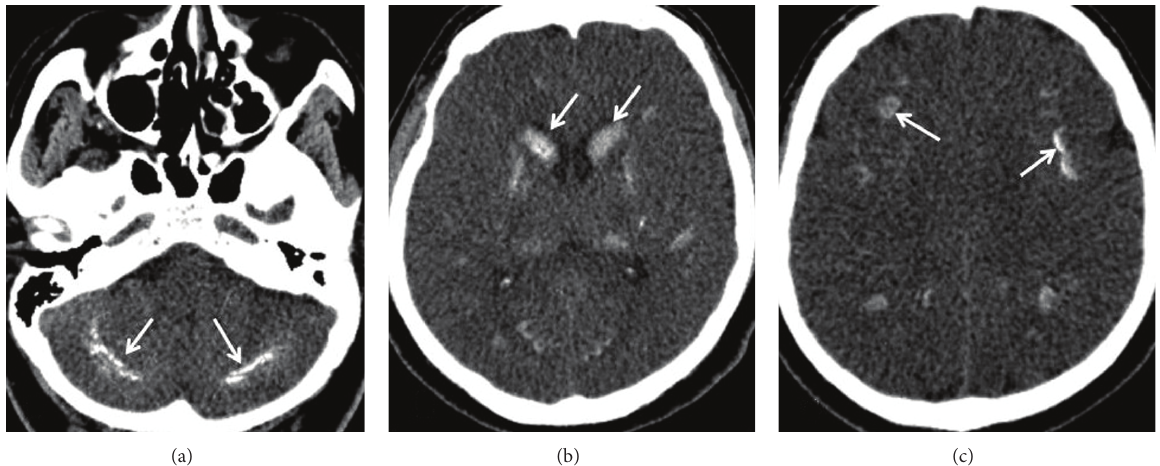
Figure 1: A large number of calcifications are observed in both cerebellar hemispheres (a), basal ganglions (b), and subcortical white matter (c) in axial CT sections (white arrows).